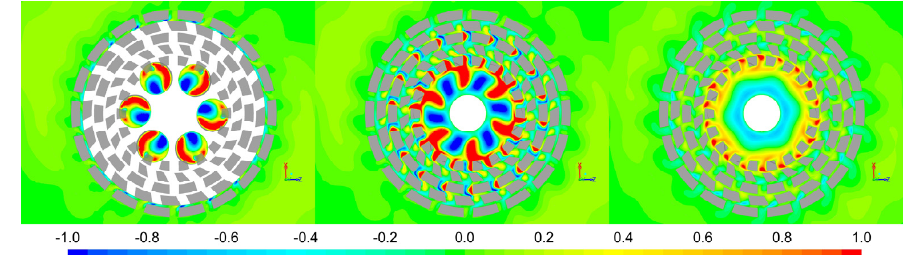
resolution” within the relevant zones of the mixing head is more relevant for the discussion than